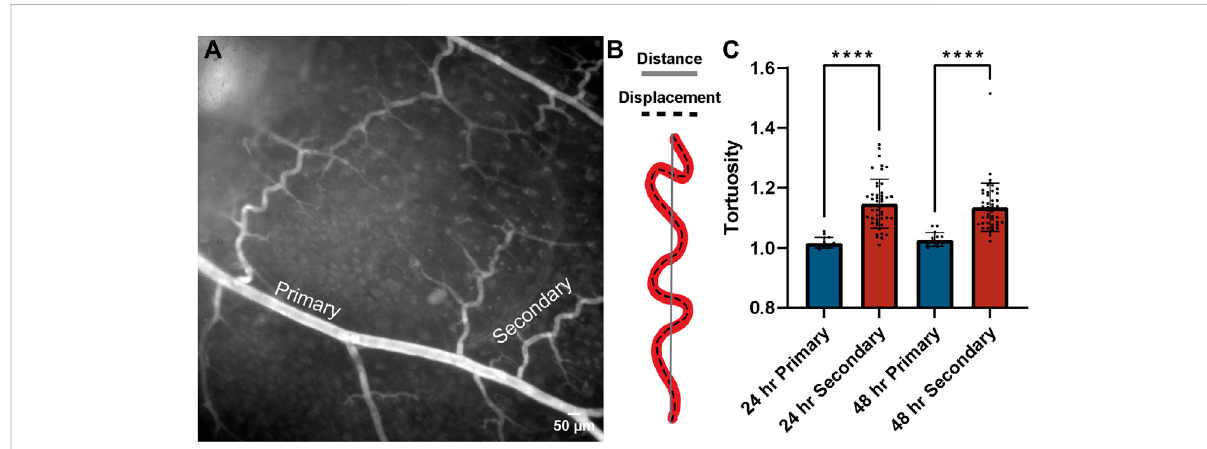
Collateral tortuosity remained increased during intestinal tissue culture in controlled fl ow conditions. (A) Representative image of intestinal tissueculturedundercontrolled fl owconditionswithprimaryandsecondarycollateralvesselsdenoted.Scalebaris50 μ m. (B) Schematicillustrating distance-metric tortuosity measurement of vessel (red) distance from end-point to end-point (solid gray line) and displacement (dashed black line). (C) Distance-metrictortuositywasmeasuredat24 h(bluebars)and48 h(redbars)inprimary( > 45 um)andsecondary( < 45 um)vesselsacross all regions relative to the area downstream of the occlusion. **** p ≤ 0.0001 for the comparisons denoted. Tortuosity was consistently lower in primary vessels than in secondary vessels across regions after both 24 h and 48 h of tissue culture with controlled fl ow. Biological replicates for this experiment were at a minimum of n = 3, and data points shown are from technical replicates across all